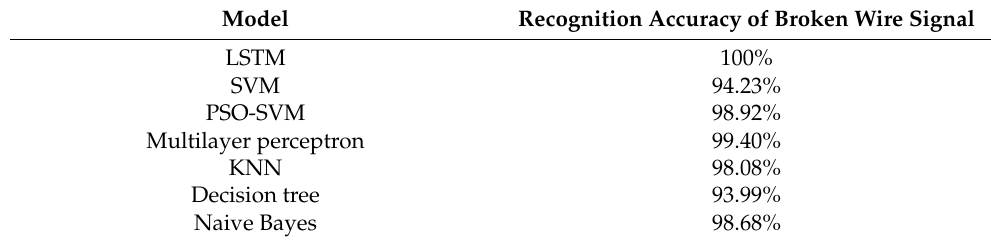
Table 8. Recognition accuracy performance (simulated signal for training, and simulated signals with Gaussian white noise (SNR = 30 dB) for test